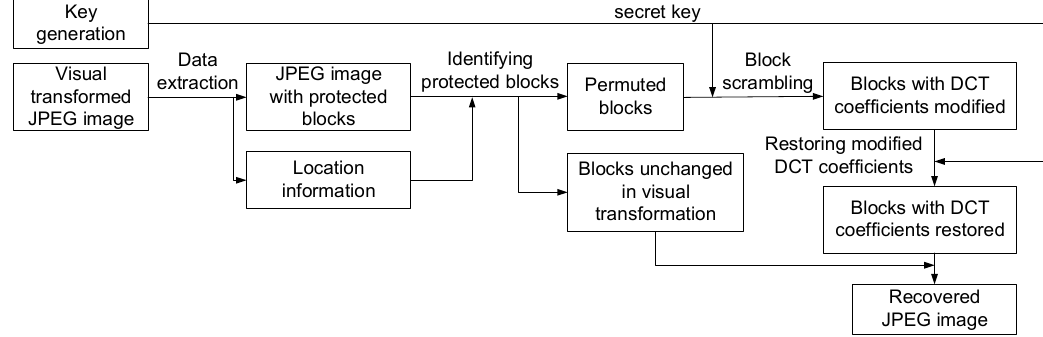
Figure 3. A flowchart of recovering the original JPEG image from the visually transformed one.